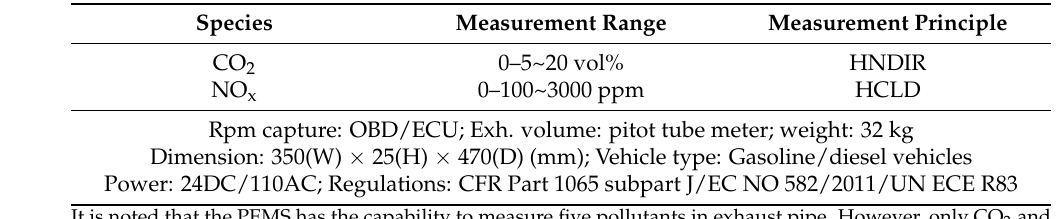
Table 2. Specifications of HORIBA OBS-ONE PEMS [32].